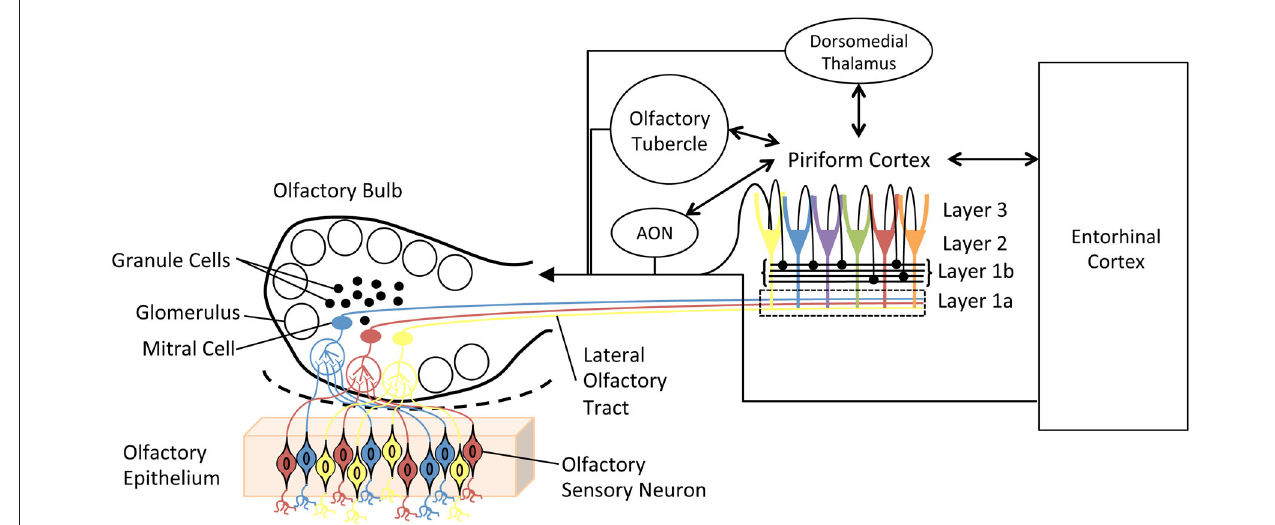
in part by OB granule cells. Granule cells undergo continual neurogenesis and replacement throughout life. Furthermore, they are a primary target of descending inputs from olfactory cortical areas. The primary olfactory cortex (piriform cortex) functions as an combinatorial, auto-associative array, allowing convergence of input conveyed from different olfactory sensory neurons. This allows merging of odorant features into odor objects. In addition to merging odorant features, the piriform cortex also has extensive, reciprocal connections with a variety of limbic and cortical